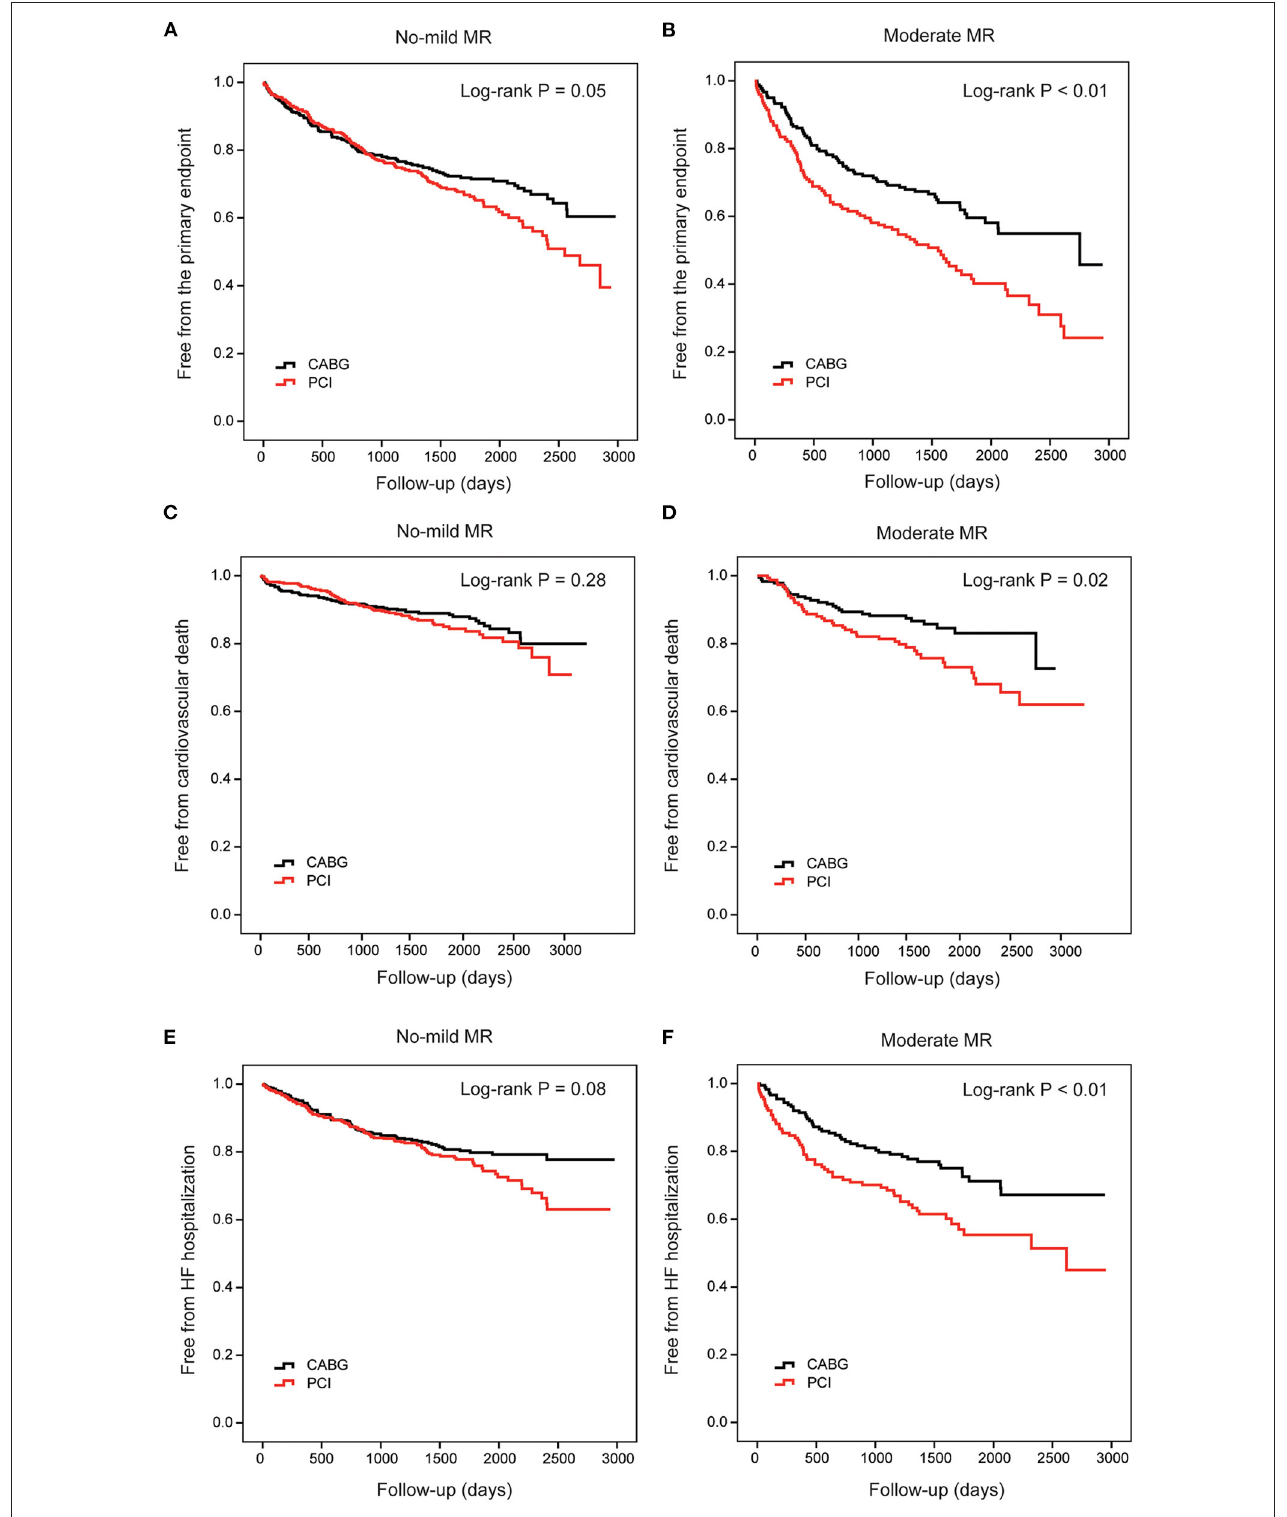
FIGURE 4 | Cumulative risks for the primary and secondary endpoints in patients stratified by MR. Kaplan–Meier survival curves of the primary endpoint in patients with no-mild MR (A) and moderate MR (B) are compared between percutaneous coronary intervention (PCI) and coronary artery bypasses grafting (CABG), respectively. Survival curves of cardiovascular death (C,D) and heart failure hospitalization (E,F) are also compared between PCI and CABG in these two groups, respectively. CABG, coronary artery bypasses grafting; HF, heart failure; MR, mitral regurgitation; PCI, percutaneous coronary intervention.